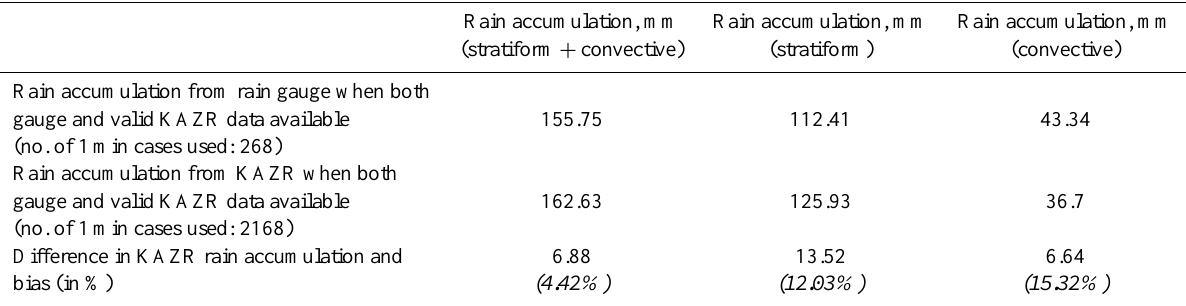
Table 4. Rain accumulation from the KAZR and optical rain gauge for the stratiform, convective, and total (stratiform + convective) rain events when data from both the instruments are available. Rain events covering over 15 days between 8 October 2011 and 6 February 2012 for the events Bias in the rain amount from the KAZR is given in